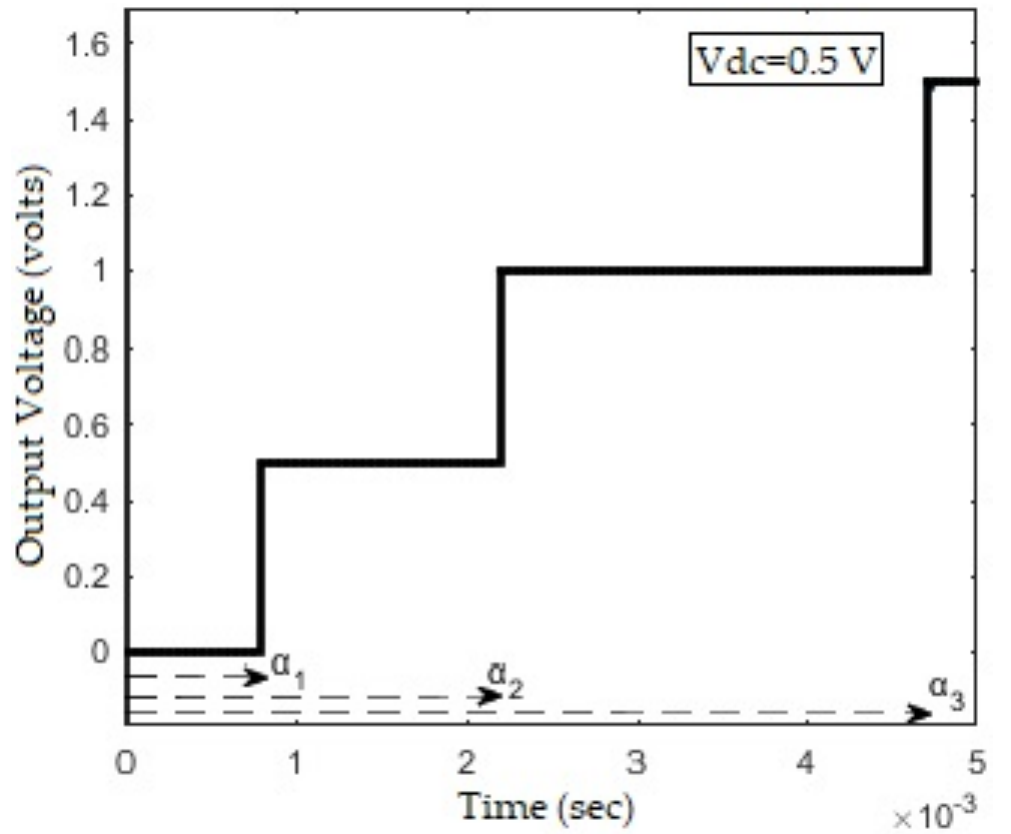
Figure 3. Switching instants in a quarter of a cycle.